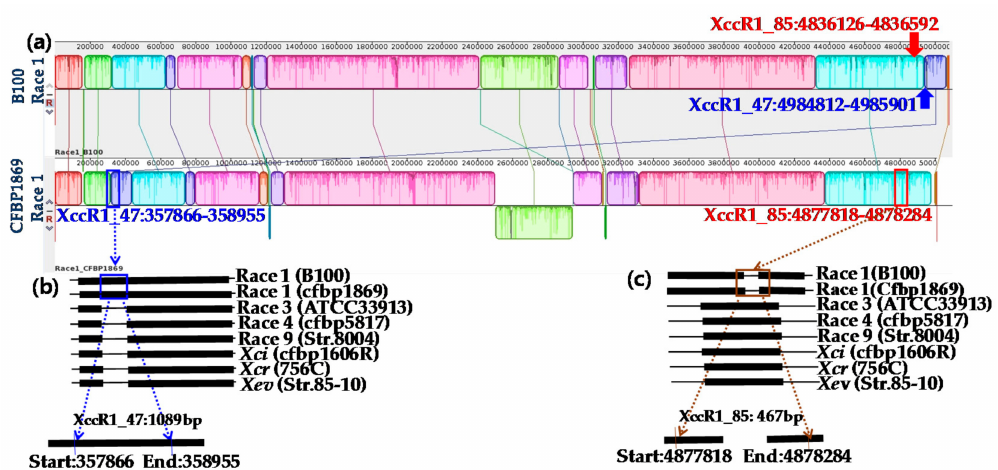
Figure 2. ( a ) A Mauve tool (version 2.4.0)-based visualization of two strains of Xanthomonas campestris pv. campestris race 1 (B100 and CFBP1869). Comparative homology of published genome sequences of Xcc and other Xanthomonas campestris pathovars developed using Geneious 8.0 (free trial) software for